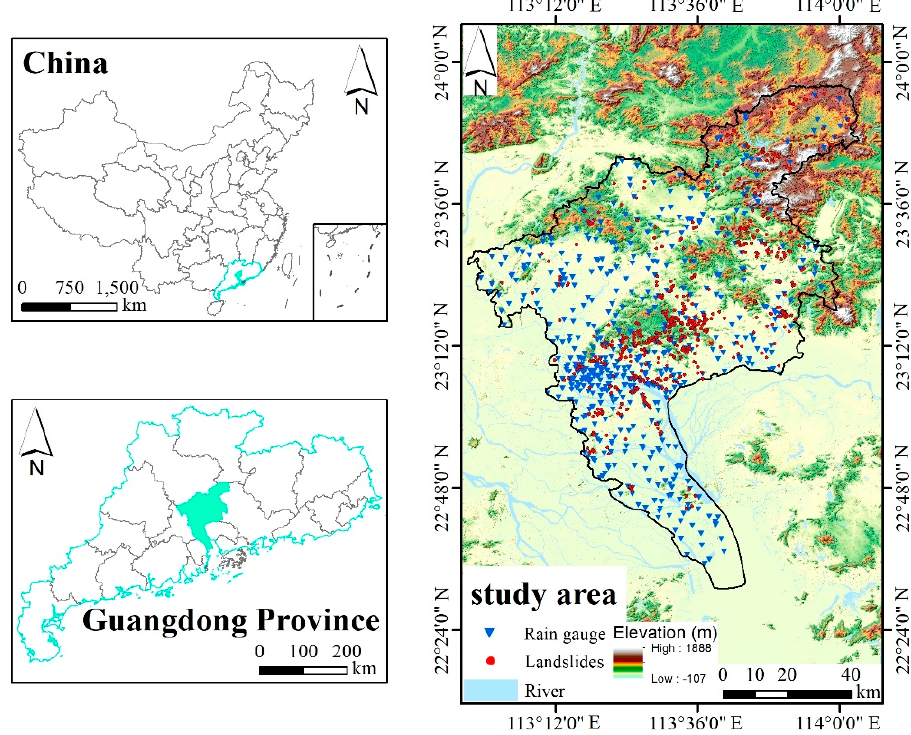
Figure 1. Distribution of landslide and rain gauge locations recorded during 2010–2020 in Guangzhou city.